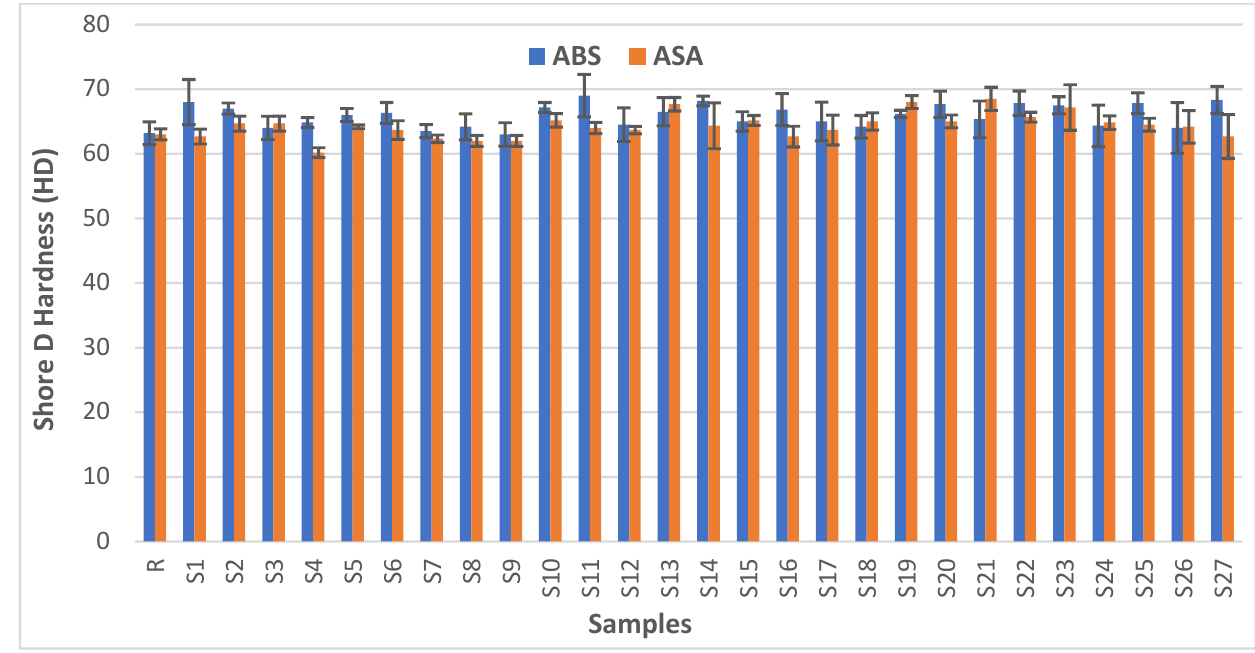
Figure 8. Hardness testing results.